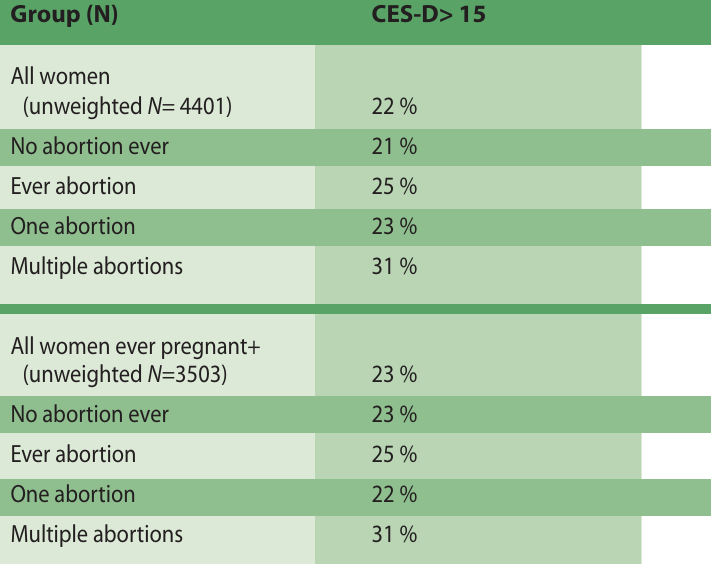
Population estimates of proportion of all women and women identified as having been pregnant exceeding CES-D clinical cutoff score,National Longitudinal Survey of